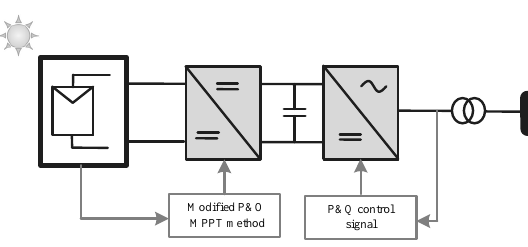
Figure 5. Schematic diagram of a two-stage grid connected PV system.